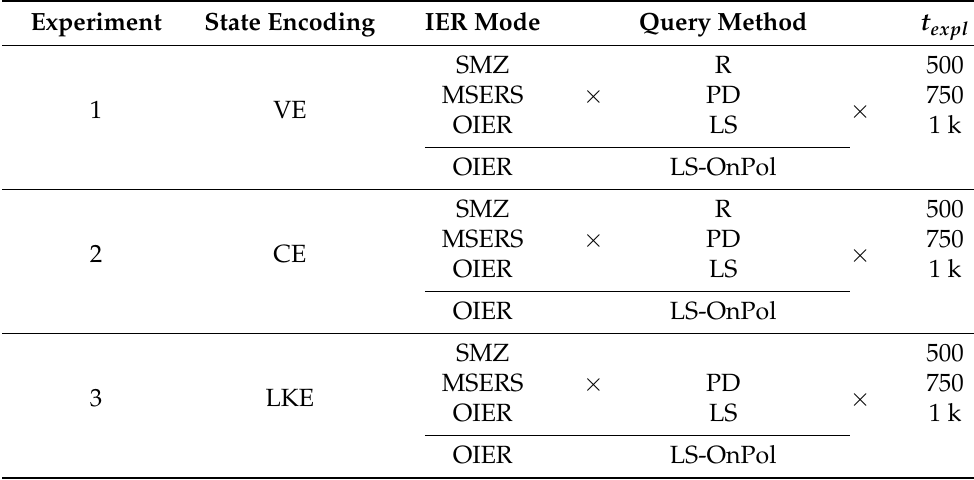
Table 5. An overview of the individually conducted experiment